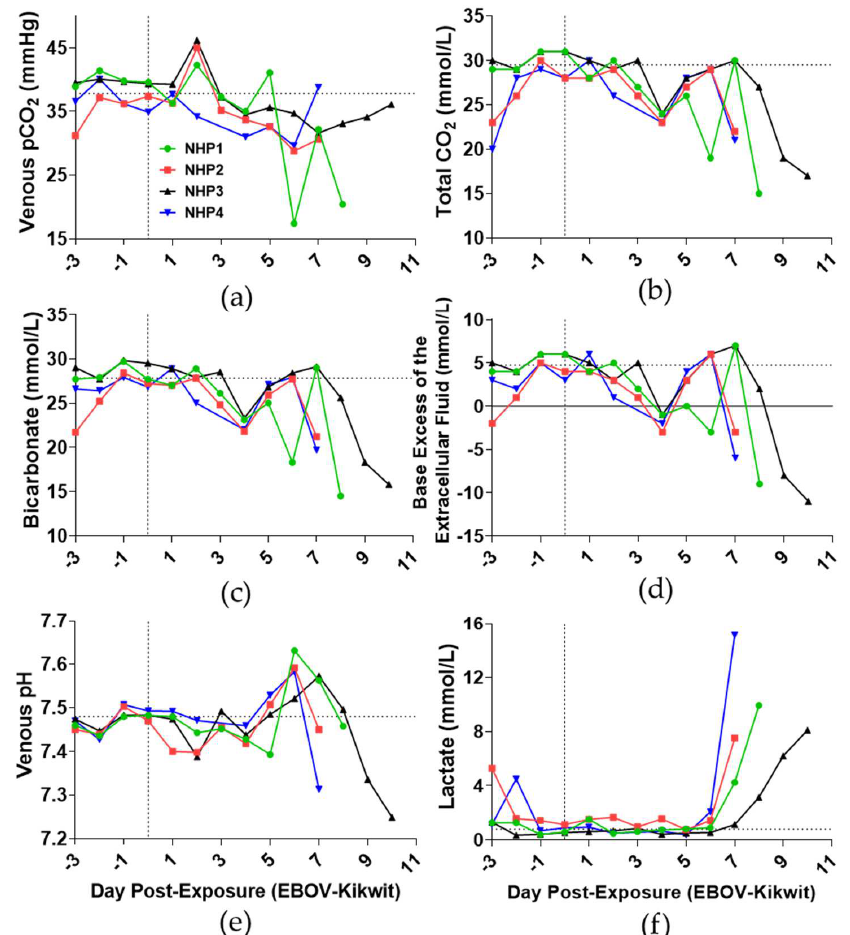
Figure 3. Time course of blood gases and constituents of EBOV-challenged rhesus macaques. Detection of ( a ) partial pressure of carbon dioxide (pCO 2 ), ( b ) total CO 2 , ( c ) bicarbonate, ( d ) base excess of extracellular fluid, ( e ) pH, and ( f ) lactate were determined in whole blood using i-Stat CG4+. DPE 0 is marked by a grey vertical dot line. The horizontal dashed line is the average of all animals for DPE 0.